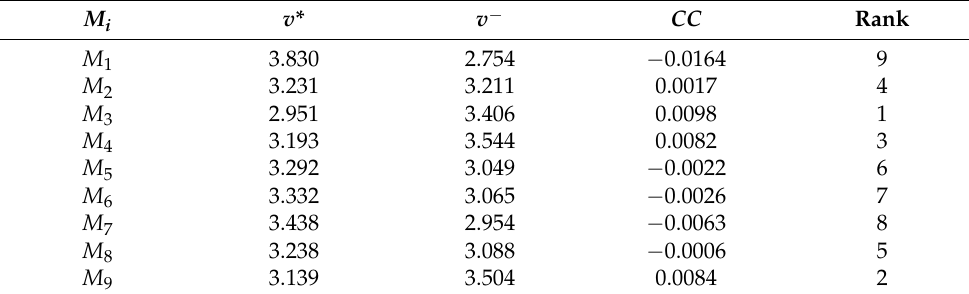
Table 12. The calculation results from the modified TOPSIS.